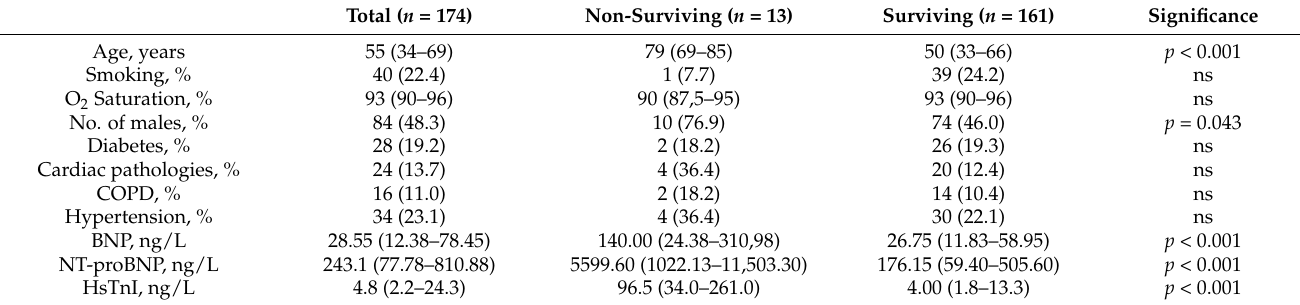
Table 1. Population description: values at admission and difference between non-surviving and surviving patients. Total ( n =